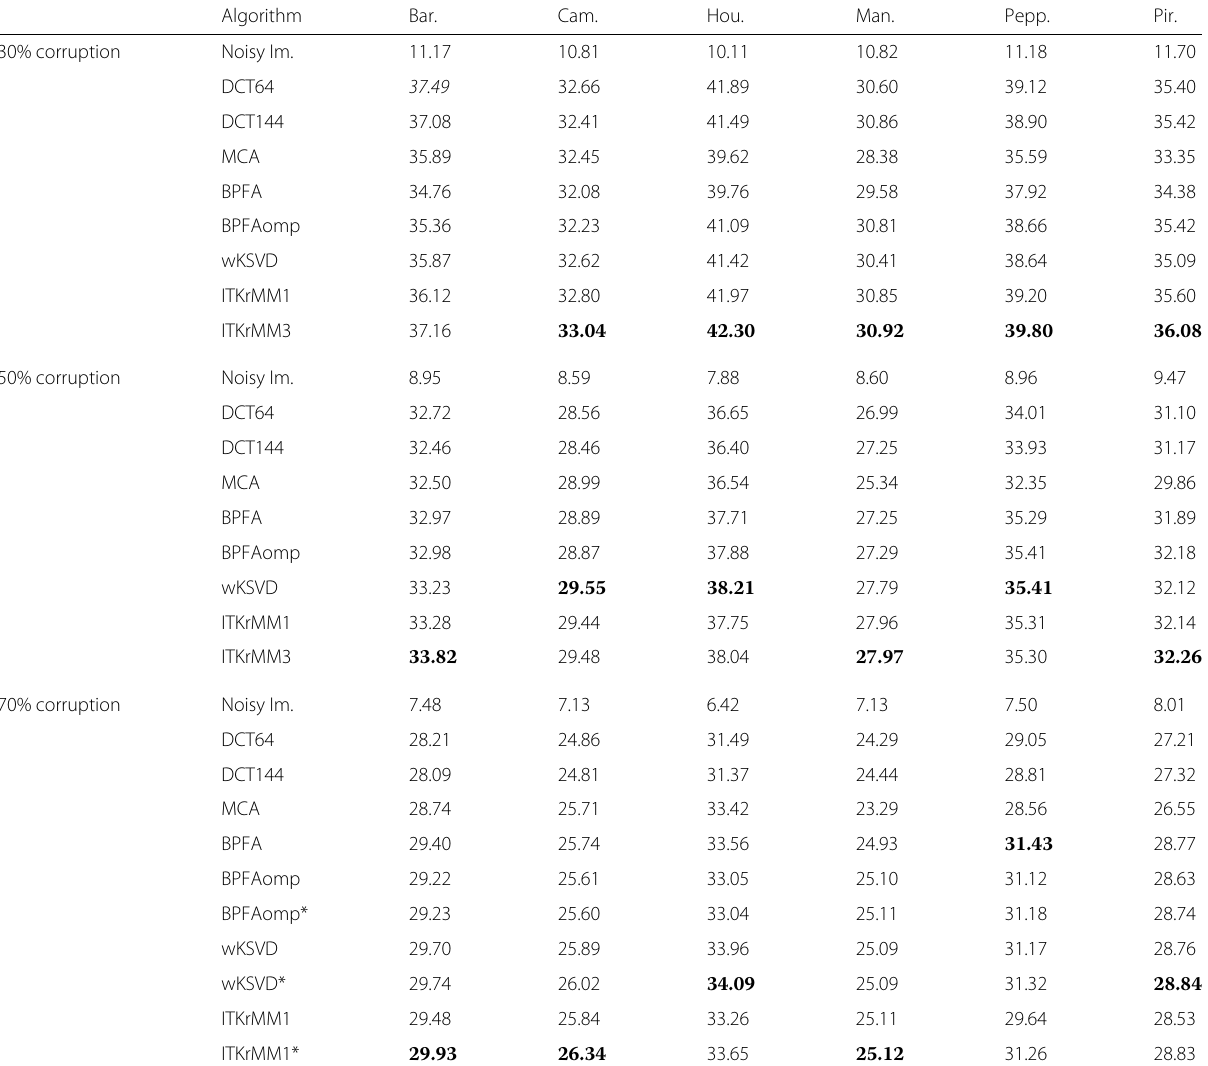
Table 4 Comparison of the PSNR (in dB) for inpainting of images with various corruption levels based on analytic dictionaries, DCT, MCA, and dictionaries learned on all available corrupted image patches, BPFA, BPFAomp, wKSVD, and ITKrMM (modified inpainting is marked with a